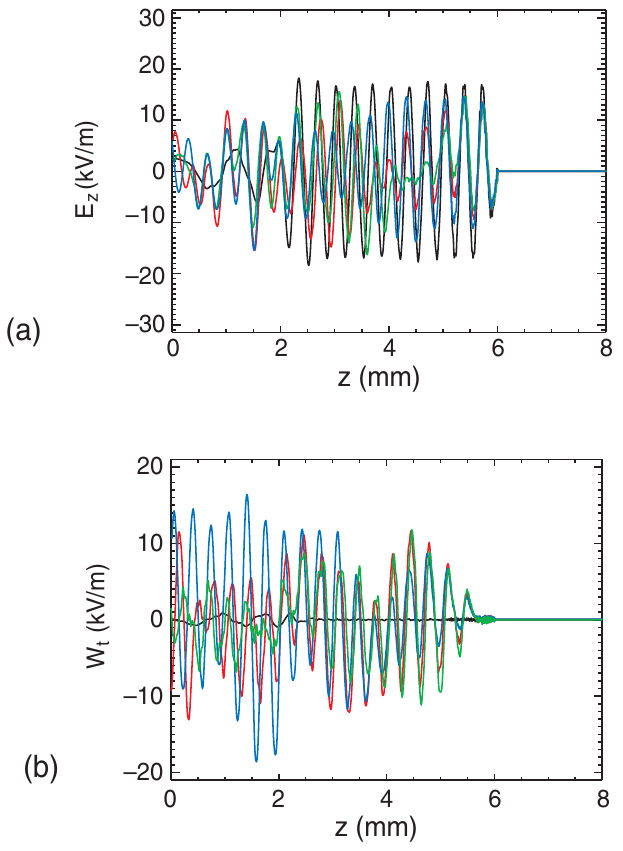
FIG. 4. (Color) Lineouts of beam wakefields as a function of axial position, for the same fixed structure geometry and electron beam parameters as in Fig. 3 but with varying slot width, as follows: black, no slots; blue, 10 (cid:2) m , red, 20 (cid:2) m , green, , along the z axis. (b) 30 (cid:2) m . (a) Longitudinal wakefields E z (cid:1) E (cid:2) cB , along the line x (cid:1) 0 ; y (cid:1) Transverse wakefields W t y z (cid:3) 33 (cid:2) m .